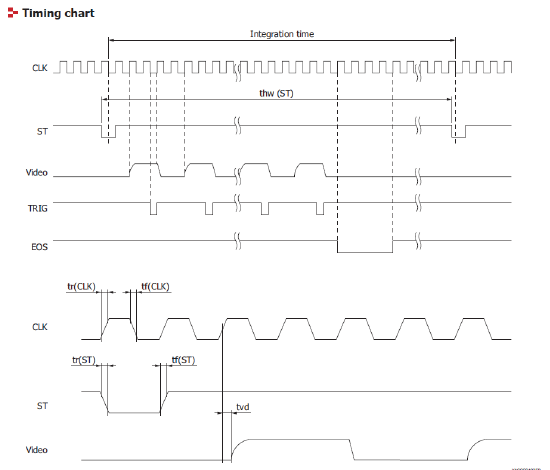
Figure A1. Timing chart for signal input and output for micro-spectrometer Hamamatsu Figure 1. Timing chart for signal input and output for micro-spectrometer Hamamatsu C12880MA